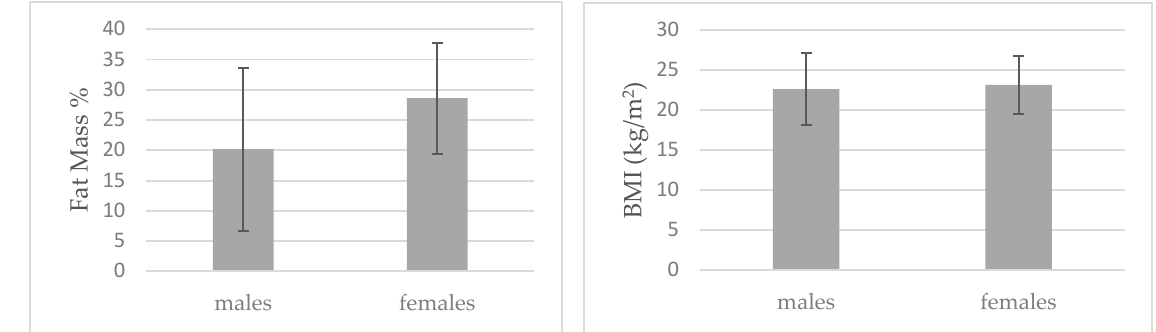
Figure 1. Mean (M) and standard deviation for fat mass percentage ( left ) and body mass index ( right ).